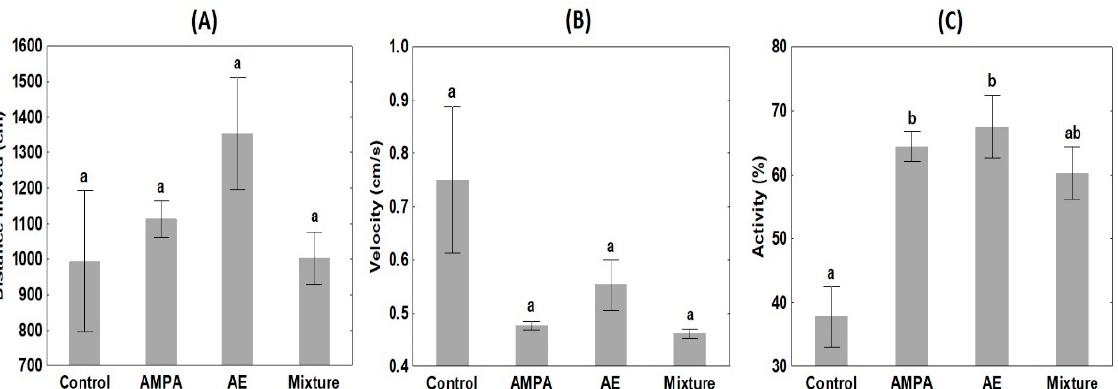
Figure 3. Distance moved ( A ), velocity ( B ), and activity ( C ) of the marbled crayfish Procambarus virginalis in untreated controls (N = 30) and groups exposed to acetochlor ESA (AE, 4.0 µg/L, N = 31), aminomethylphosphonic acid (AMPA, 4.0 µg/L, N = 32) and their combination (AE, 4.0 µg/L + AMPA, 4.0 µg/L, N = 29); different superscripts indicate significant difference among groups ( p < 0.01). Data are means ±